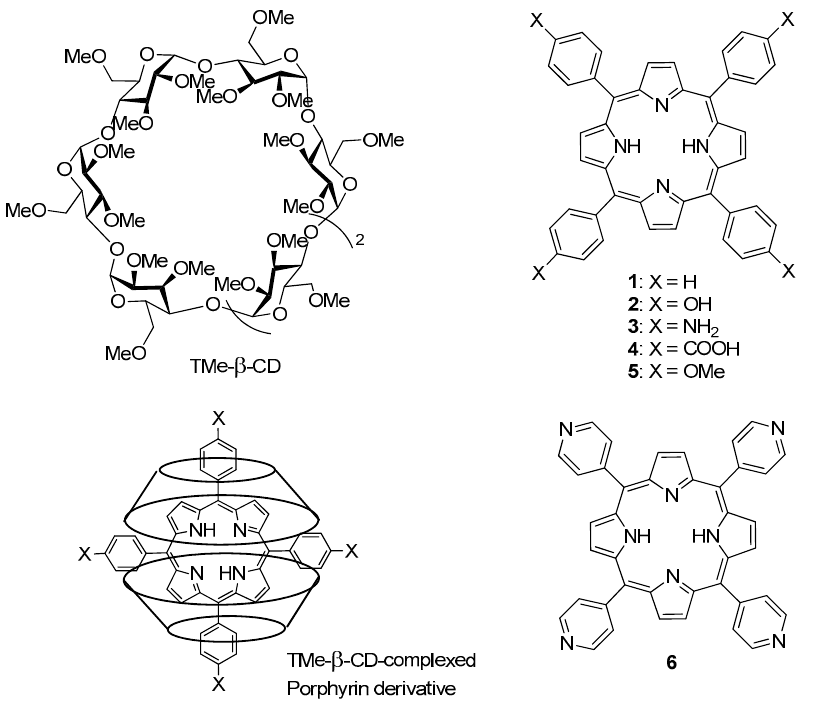
Figure 14. Chemical structure and schematic illustration of the trimethyl- β -CD (TMe- β -CD) complexed with porphyrin derivatives.